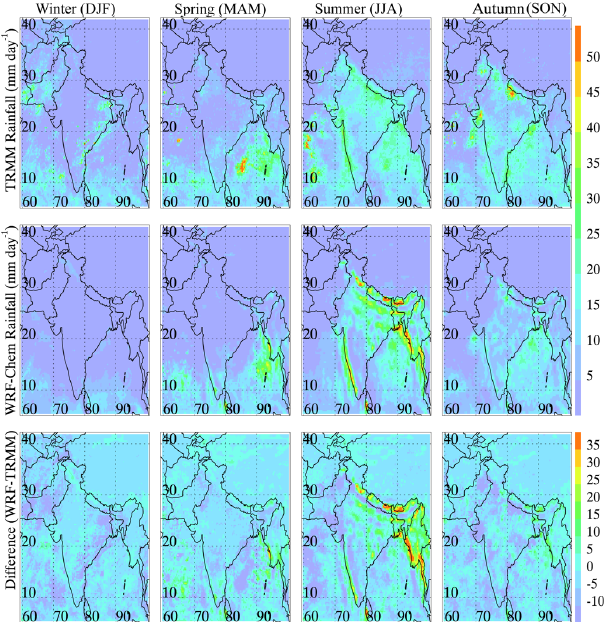
Fig. 10. Spatial distribution of co-located TRMM (top panel) and WRF-Chem (second panel) total precipitation during the winter, spring, summer and autumn seasons of the year 2008. Difference (WRF-TRMM) in the total precipitation values are shown in the bottom